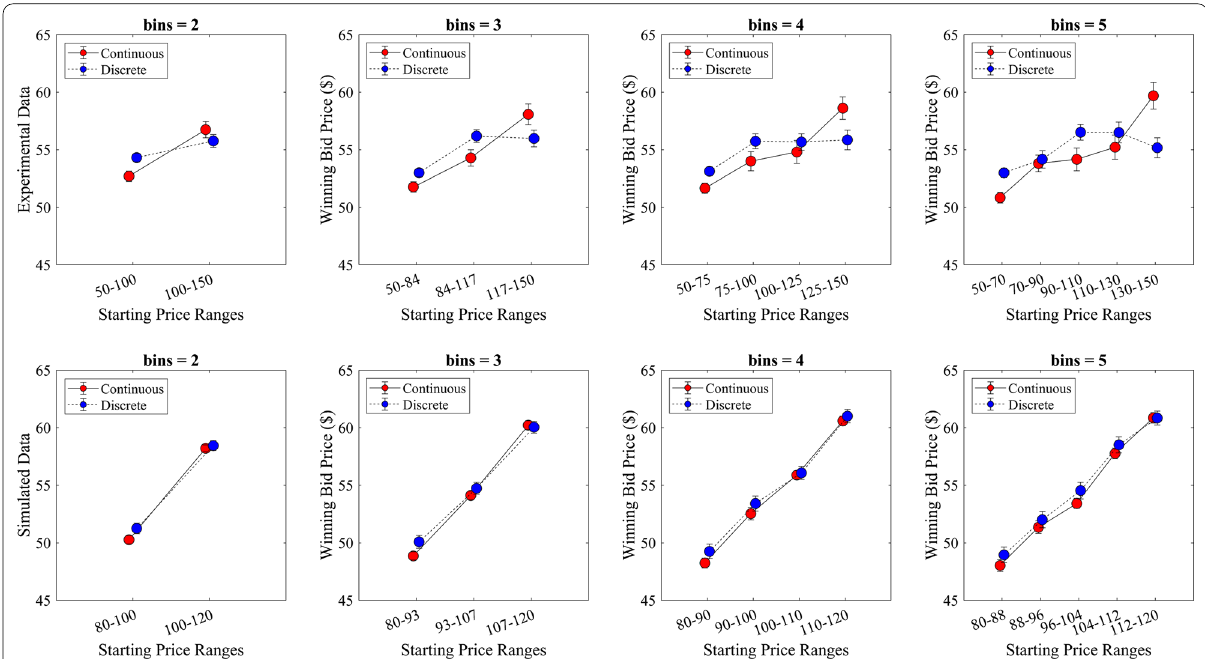
Fig. 16 Experimental Data (top) compared to model simulated data (bottom) for both the continuous (red) and discrete (blue) conditions